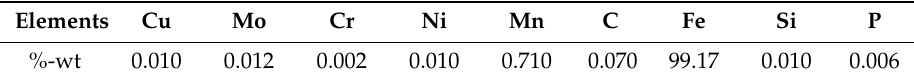
Table 1. Elemental composition of the carbon